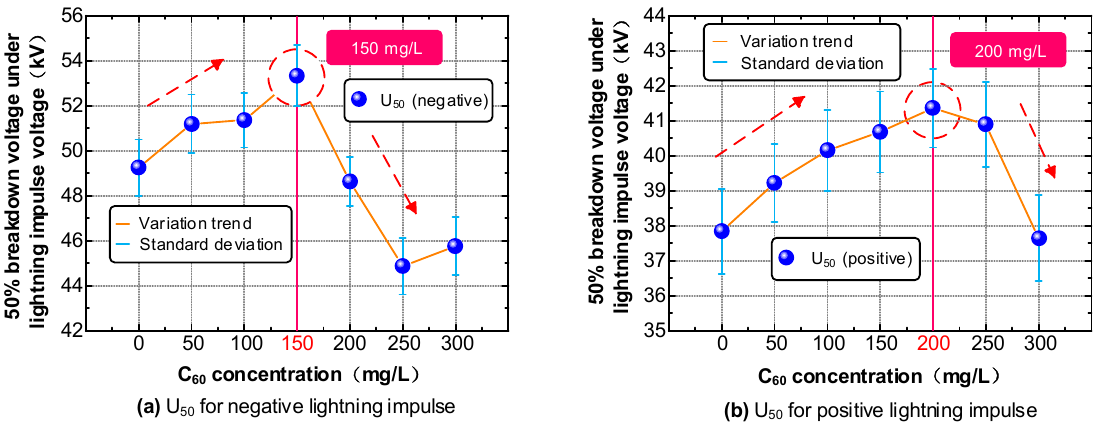
Figure 6. Lightning breakdown characteristics of CMIO and FO. ( a ) U 50 for negative lightning impulse, ( b ) U 50 for positive lightning impulse.